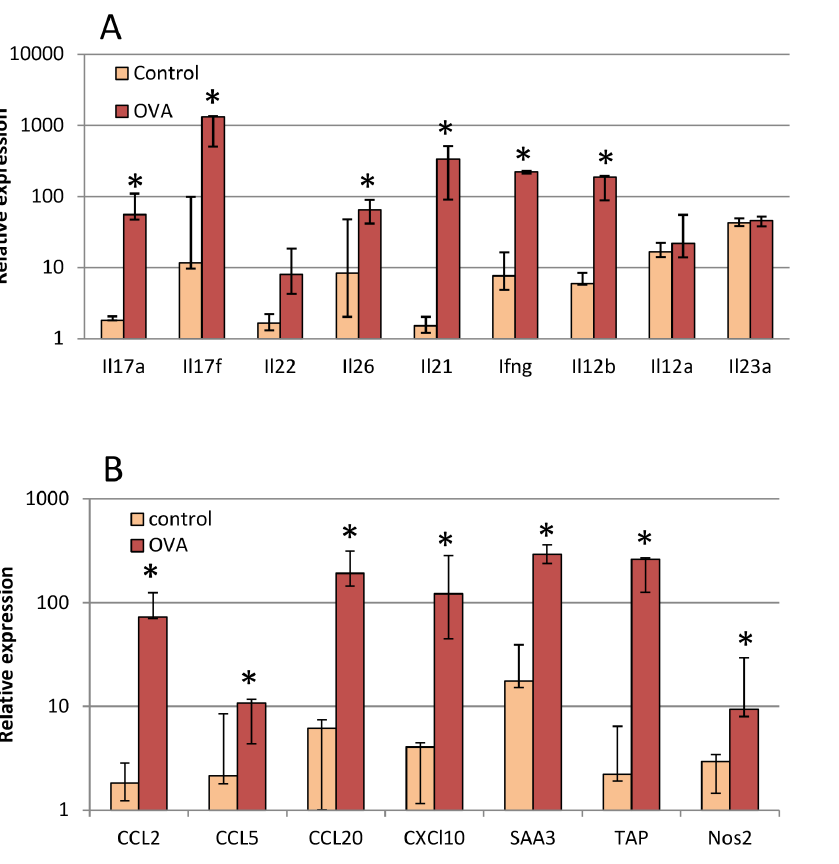
Figure 7. Characterization of cytokine expression in mammary tissue following intramammary challenge with ovalbumin. Five responder cows were challenged in one quarter with 25 m g ovalbumin and mammary tissue was collected for RT-qPCR about 14 h later. A) Relative expression of cytokines associated with lymphocytes or considered as stimulating the expression of these cytokines by lymphocytes. B) Relative expression of genes coding chemokines and defense components. * significant difference (p , 0.05; permutation test for paired samples) between challenged and control quarters.